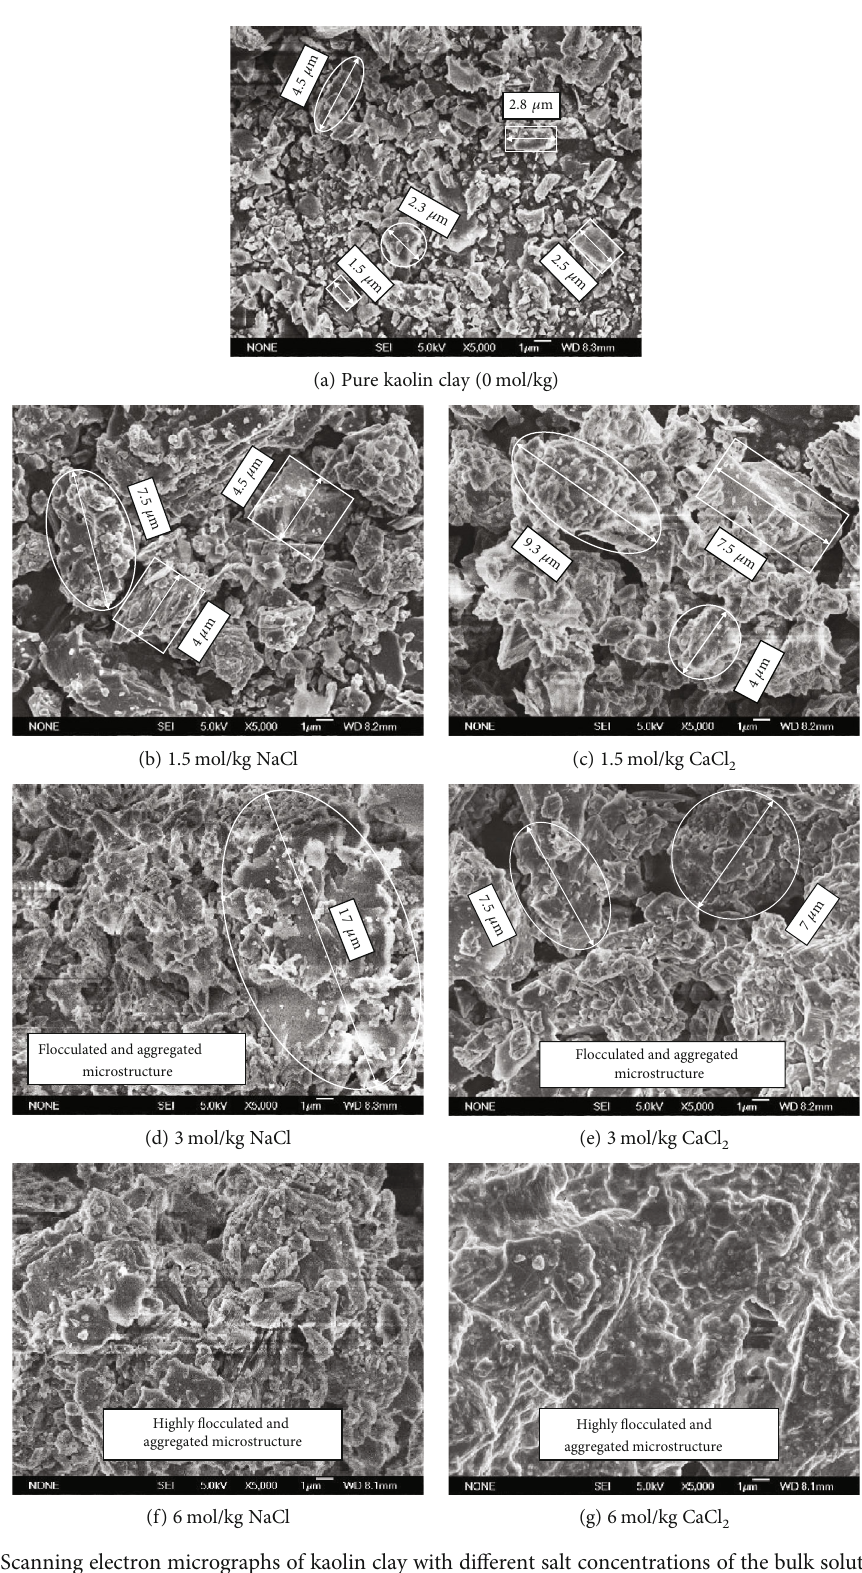
Figure 12: Scanning electron micrographs of kaolin clay with di ff erent salt concentrations of the bulk solution ( ×